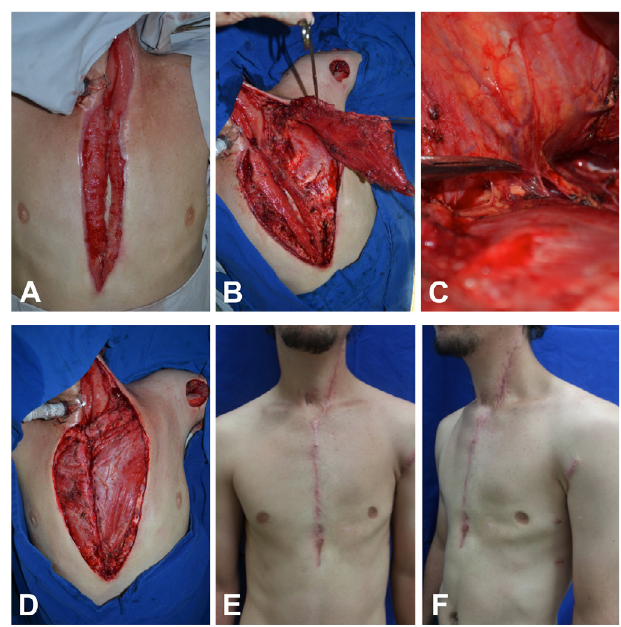
Fig. 1 - A 21-year-old man with sternal wound dehiscence due to mediastinitis after Ludwig's syndrome. (A) Cervical-sternal wound dehiscence. (B) Transposition of the left pectoralis major muscle flap after the section of its origin at the humerus. (C) Left thoraco-acromial pedicle. (D) Flap positioned and fixed, covering the entire extent of the sternal cleft. (E and F) Four months after surgery.